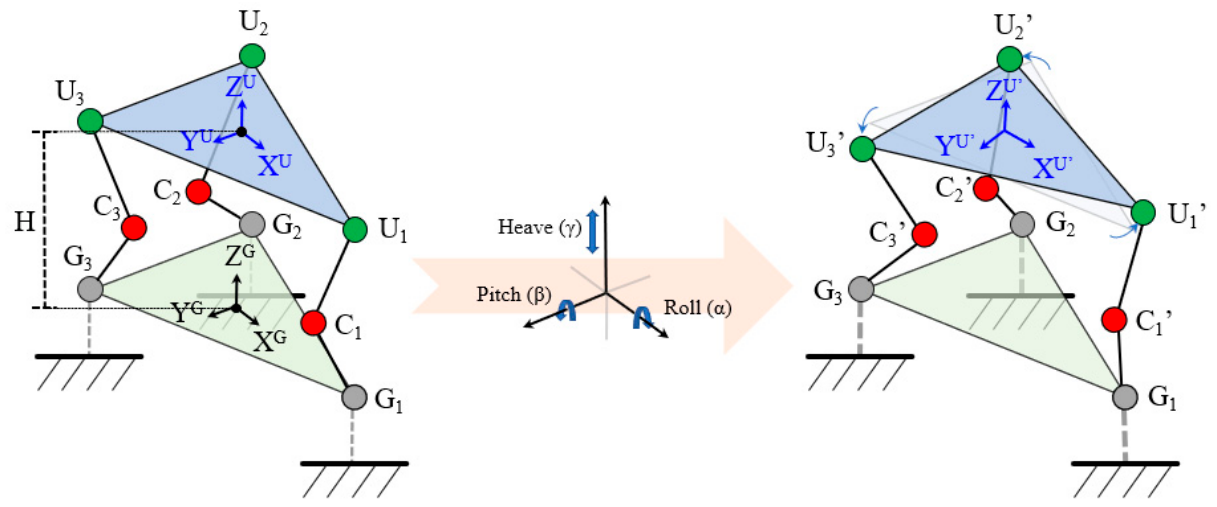
Figure 5. The basic Cartesian coordinate system of the 3-degrees of freedom (DoF) platform.